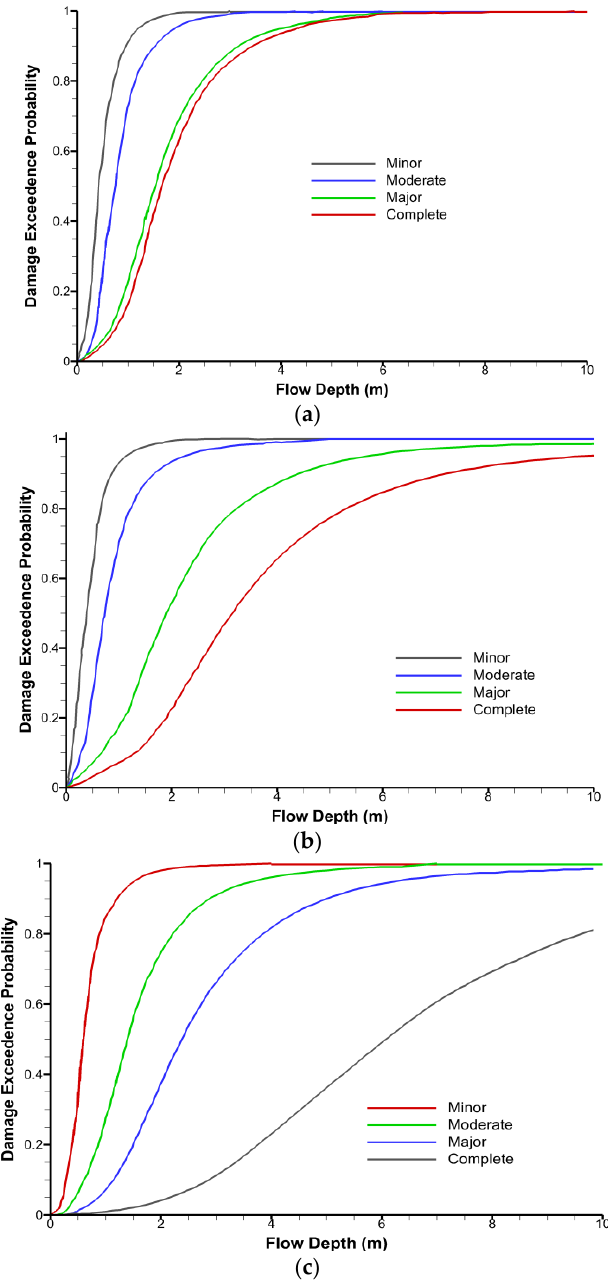
Figure 9. Fragility curves for ( a ) wood; ( b ) masonry; and ( c ) RC, as proposed in [9].